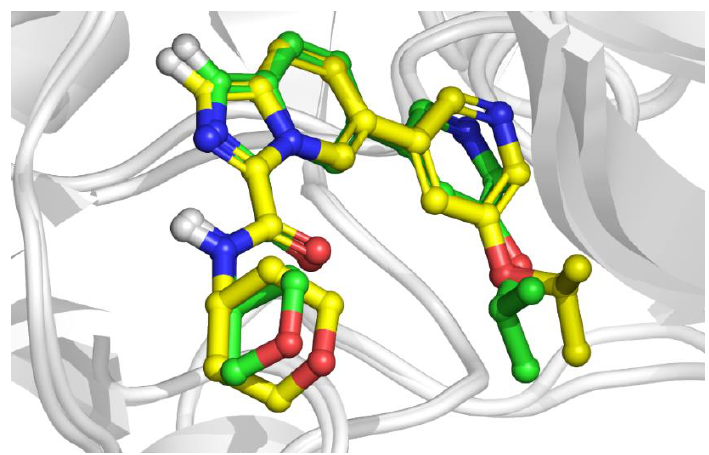
Figure 5. Overlap of the docking poses (yellow) versus co-crystal structure (green) of 16 in the complex with GSK- 3β enzyme.